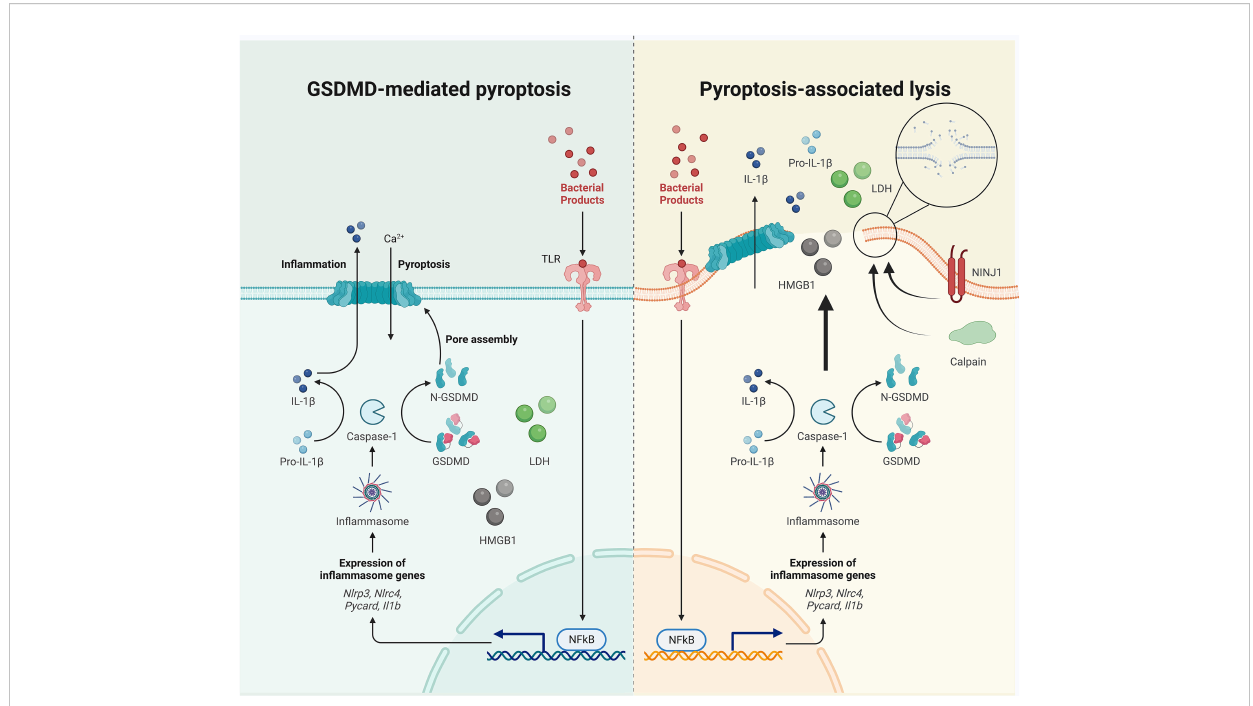
FIGURE 1 Pyroptotic cell death occurs before cell lysis. The separation of GSDMD pore formation and cell membrane rupture are evidenced by the differential release mechanisms of intracellular contents: IL-1 b is secreted through GSDMD pores and ruptured cell membranes, and HMGB1 and LDH leak (if not always) via cell lysis. Cell swelling and plasma membrane rupture could be active events mediated by calpain and NINJ1, although unbalanced osmotically permeability induced by GSDMD pore formation may also contribute to passive